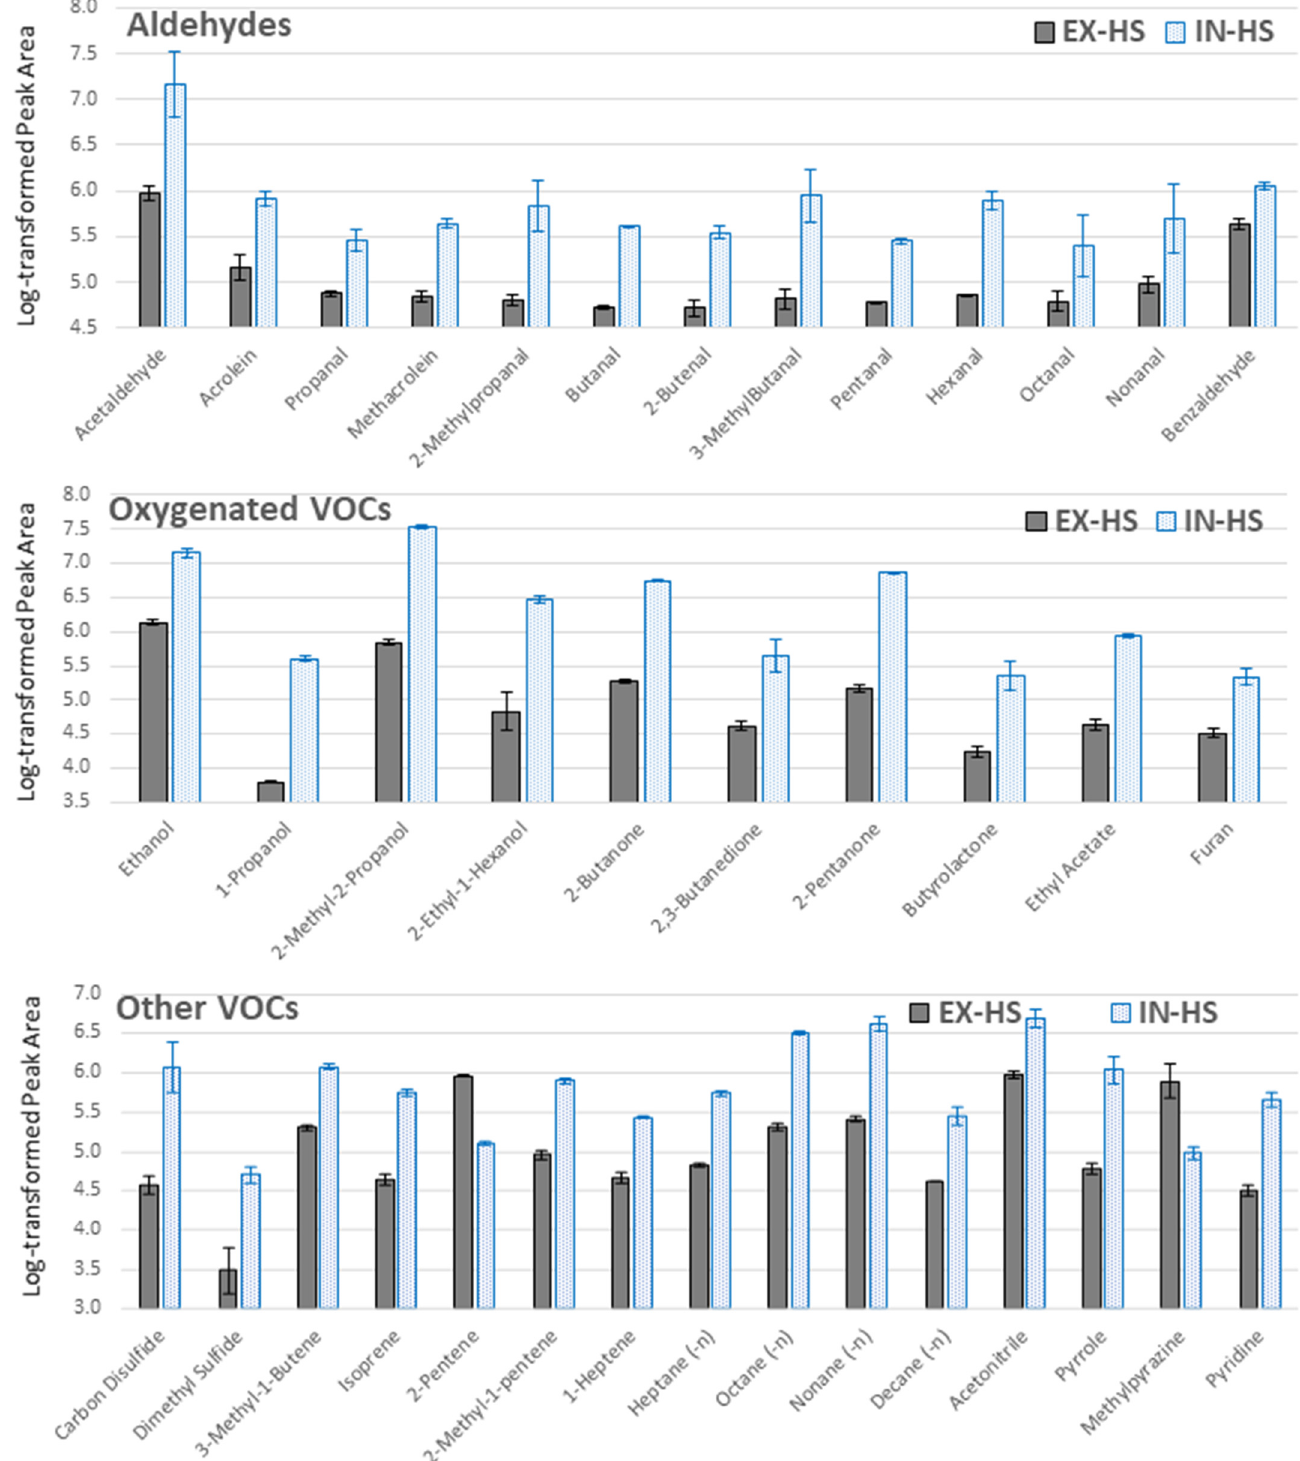
Figure 2. Optimization of sampling protocol for VOCs extraction from a pooled medium headspace. The y -axis represents log-transformed peak area values, where means are given with a respective standard deviation for three replicates ( n = 3) for each sampling mode: external headspace (EX-HS, grey boxes) and internal headspace (IN-HS, blue boxes).